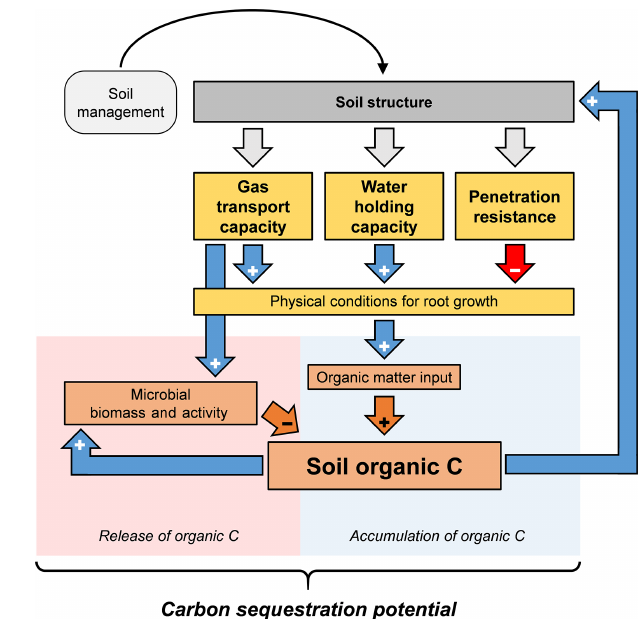
Figure 5. Conceptual model illustrating the influence of soil struc- ture and related soil physical properties on soil organic carbon con- tent. Improved soil aeration, water holding capacity, and soil pene- trability lead to better physical conditions for root growth, which fuels soil organic matter input and increases soil organic carbon content. In turn, soil structure and related physical properties are further improved. Improved soil aeration and high soil organic car- bon content may also fuel microbial growth and activity and thus accelerate soil organic matter